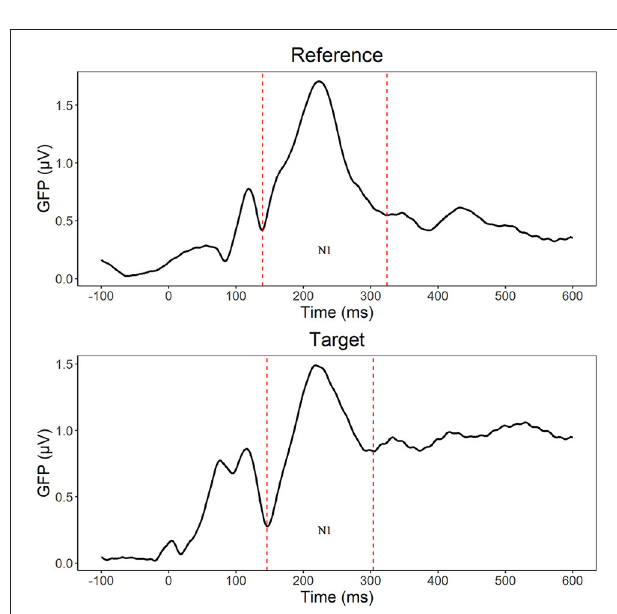
FIGURE 2 | N1 segmentation (dashed line) based on Global Field Power (GFP) separately for reference (139–324ms) and target (146–304ms) stimuli.